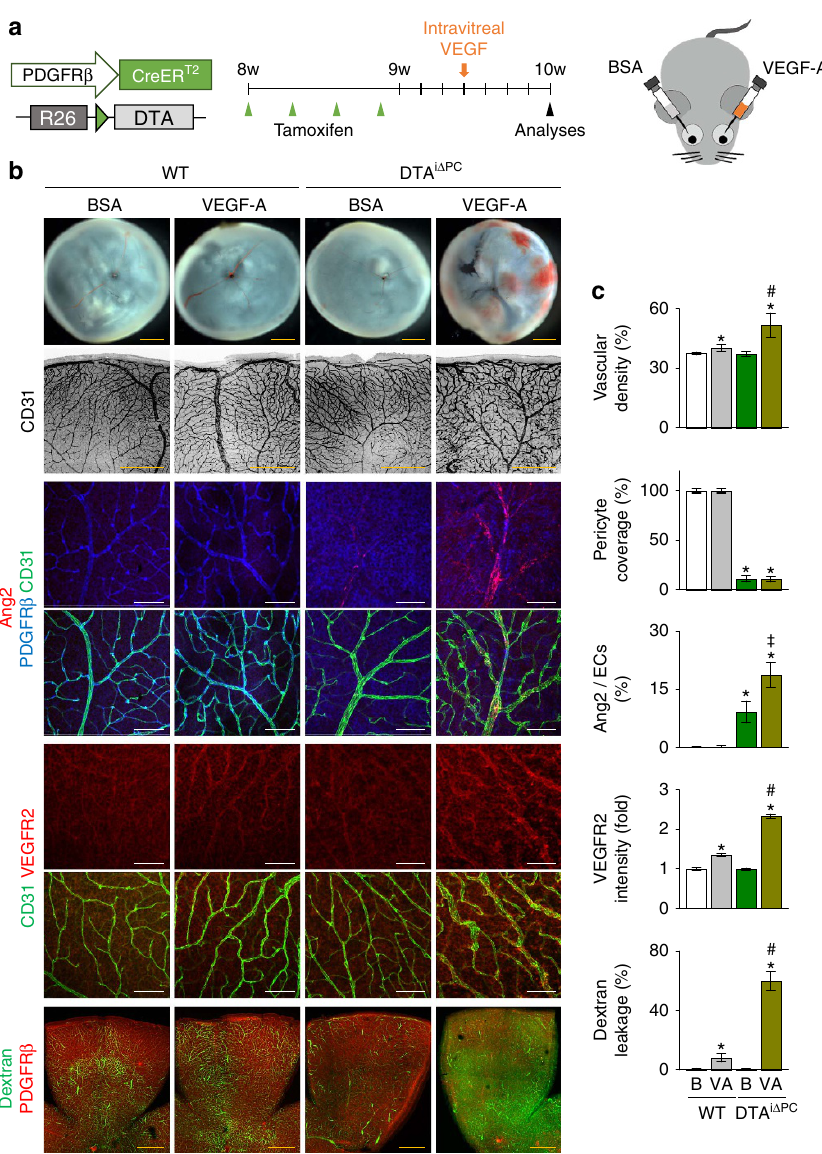
Figure 9 | Additional VEGF-A is required to recapitulate the phenotypes of DR. ( a ) Diagram depicting the experiment schedule for selective loss of pericytes in retinal vessels using adult DTA i D PC mice, intra-vitreal administration of VEGF-A (1 m g) into one eye and BSA (1 m g) into the contralateral eye, and analyses at 4 days after the administration. ( b , c ) Images and comparisons of inner surface of retinal cup, CD31 þ vessels, PDGFR b þ pericyte coverage, expressions of Ang2 and VEGFR2 in CD31 þ vessels, and dextran (70kDa) leakage in retinas of WTand DTA i D PC mice that were intra-vitreally treated with BSA (B) or VEGF-A (VA). Each group, n ¼ 6. Error bars represent mean ± s.d. * P o 0.01 versus WT treated with B, z P o 0.01 versus DTA i D PC treated with B, # P o 0.01 versus WT treated with VA by Kruskal–Wallis test. Scale bars, 100 m m (white) and 500 m m